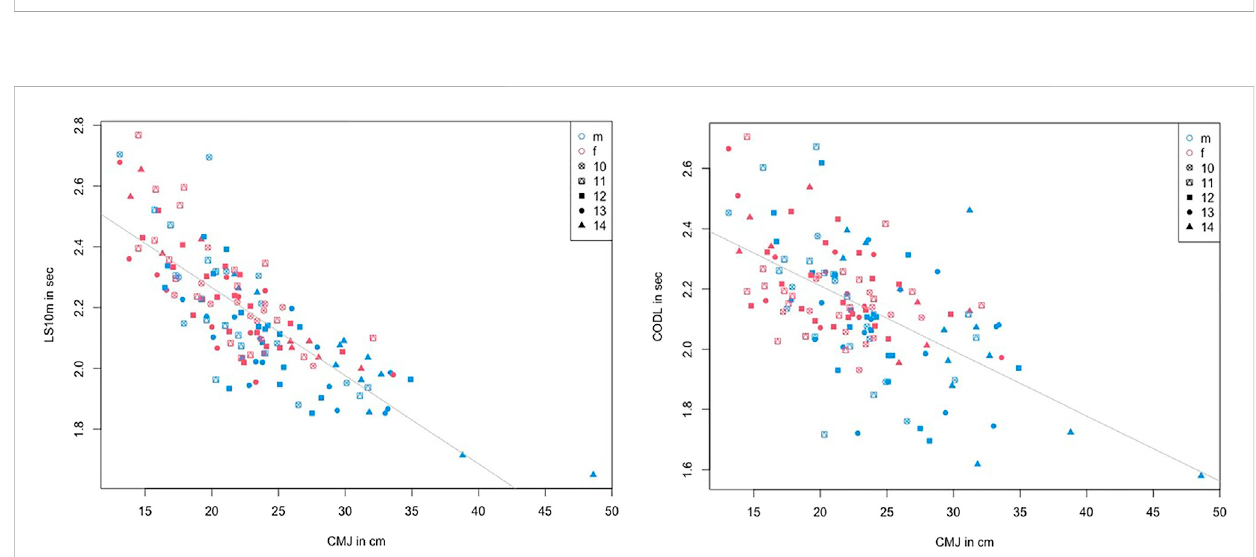
FIGURE 4 Correlation coef fi cients between linear sprint (10 m) and CMJ height, and COD sprint and CMJ height considering age and sex.